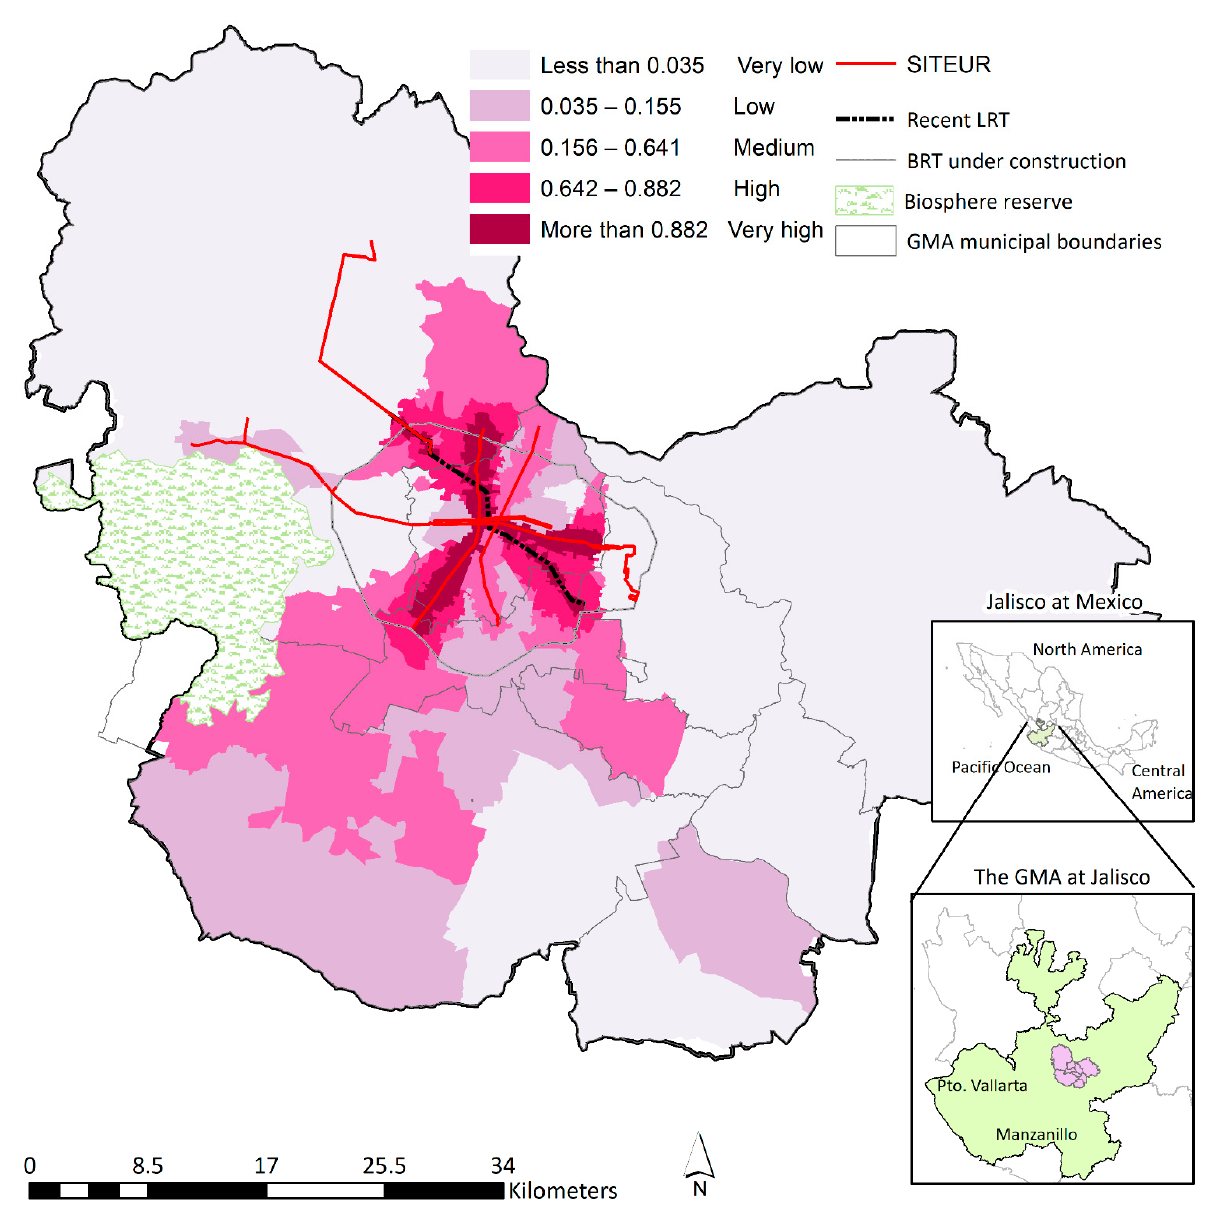
Figure 4. Index of Mass Transport Provision. Source: Authors, based on [42,43,45–50].